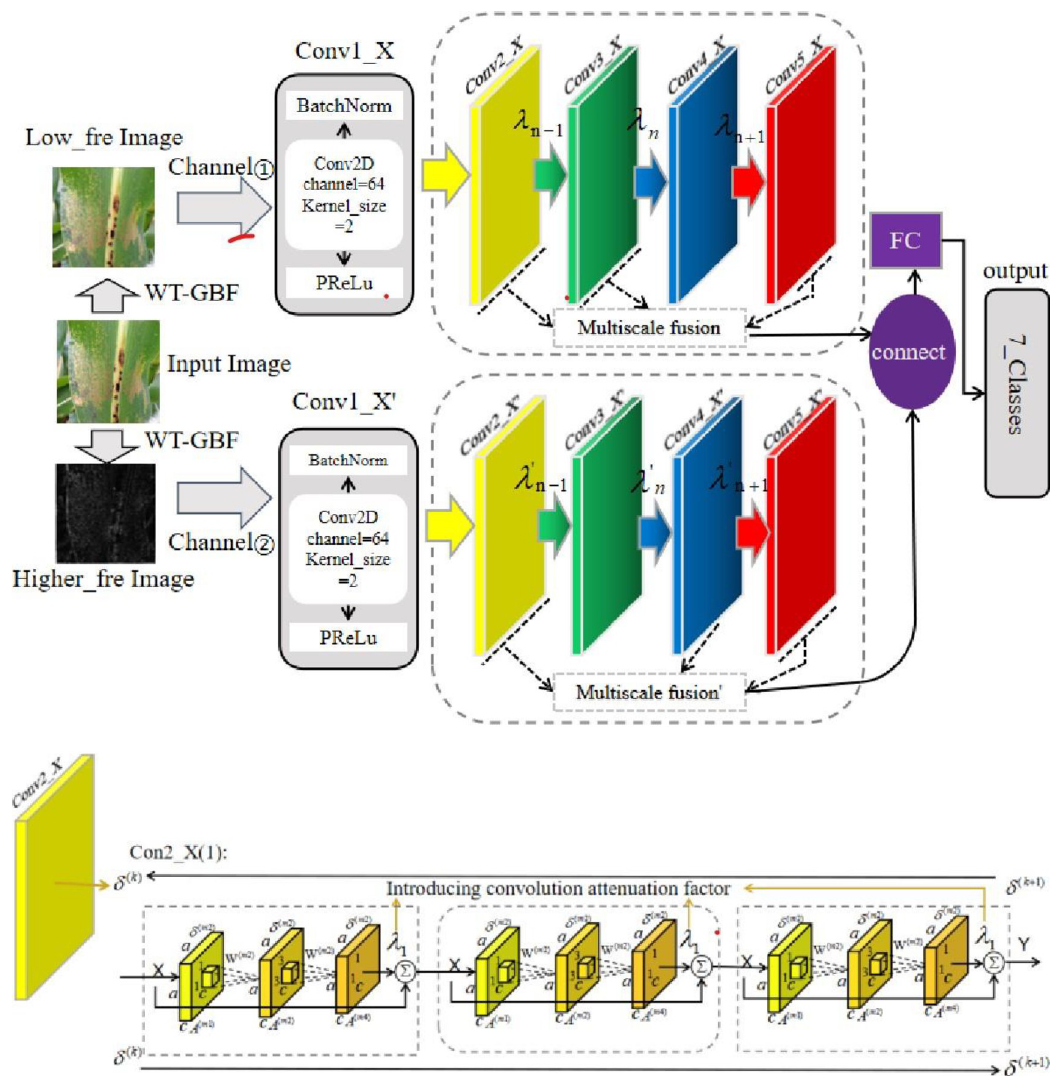
Fig 2. Structure diagram of the